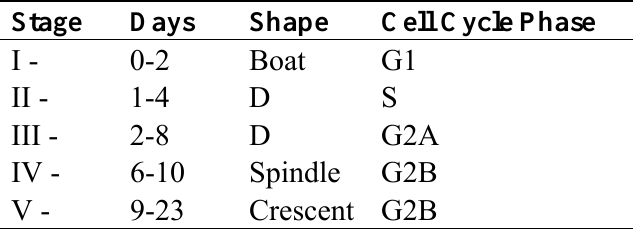
Table 1. Developmental stages of gametocytes